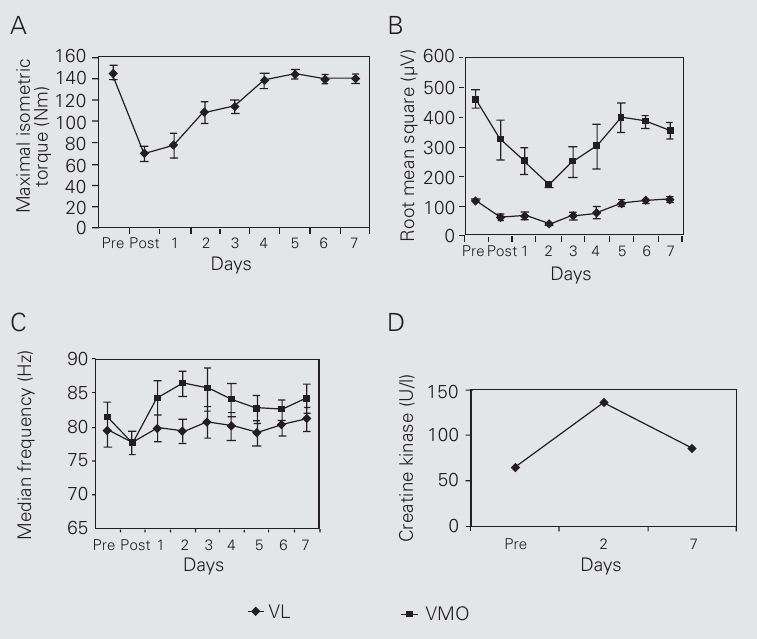
Figure 1. Effect of eccentric exercise on maximal isometric torque (A), root mean square (B), median frequency (C), and creatine kinase (D) before (Pre) and immediately after (Post) exercise, and on the 7 days following exercise. Results are reported as means ± SD for one female subject. VL = vastus lateralis; VMO = vastus medialis